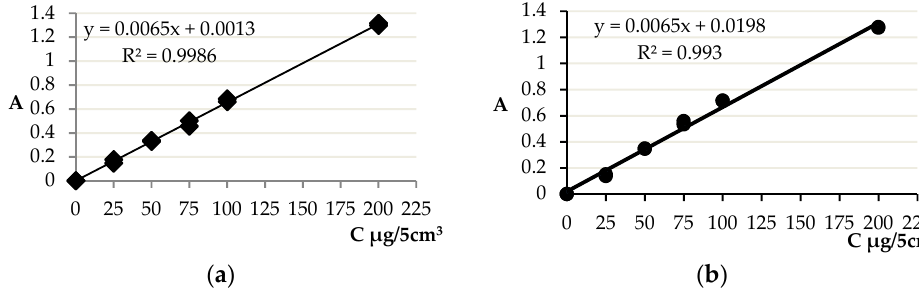
Figure 8. Standard curves of gallic acid in ( a ) methanol and ( b ) in water. For the determination, 300 µL of filtered infusion of fresh leaves or tea or 75 µL of methanol or water extract were taken, which were made up to 300 µL with extraction solution. Then 4.15 mL of deionised water, 500 µL of 20% sodium carbonate solution, and 50 µL of Folin-Ciocalteu reagent were added. The reagents were mixed and allowed to stand for 20 min. The absorbance was measured at a wavelength of 700 nm on a SHIMADZU UV-1201V (Japan) spectrophotometer. Total polyphenol content was calculated on the basis of a standard curve (prepared for each variant) and expressed as gallic acid equivalent per 100 g of product dry matter.